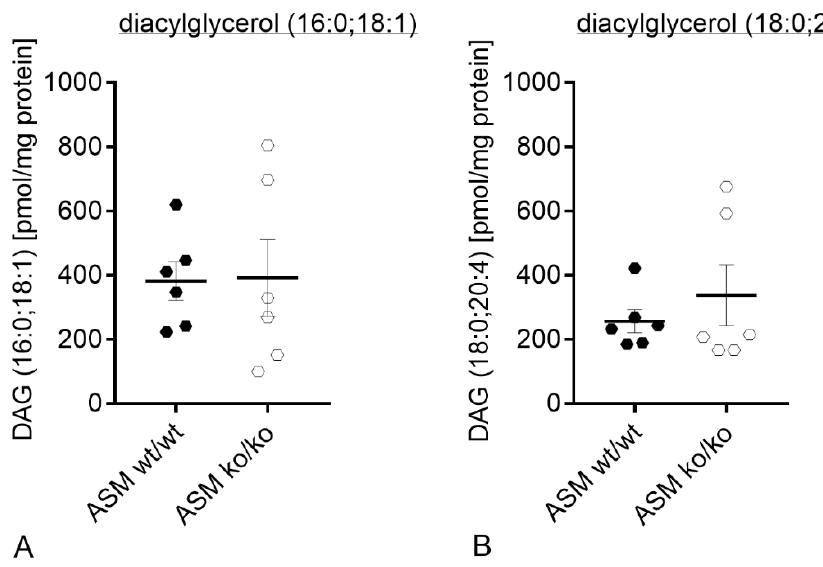
Figure 3. Genetic ASM deficiency does not affect diacylglycerol levels in the murine frontal cortex. ( A ). Deletion of ASM showed no significant impact on DAG (16:0; 18:1) or ( B ). DAG (18:0; 20:4) concentrations in frontal cortex. Bars indicate mean ± SEM; n = 6 animals.